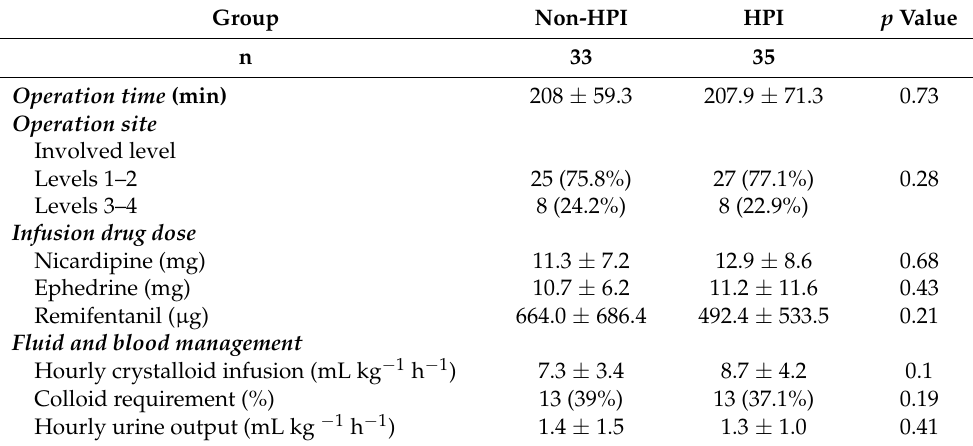
Table 2. Intraoperative